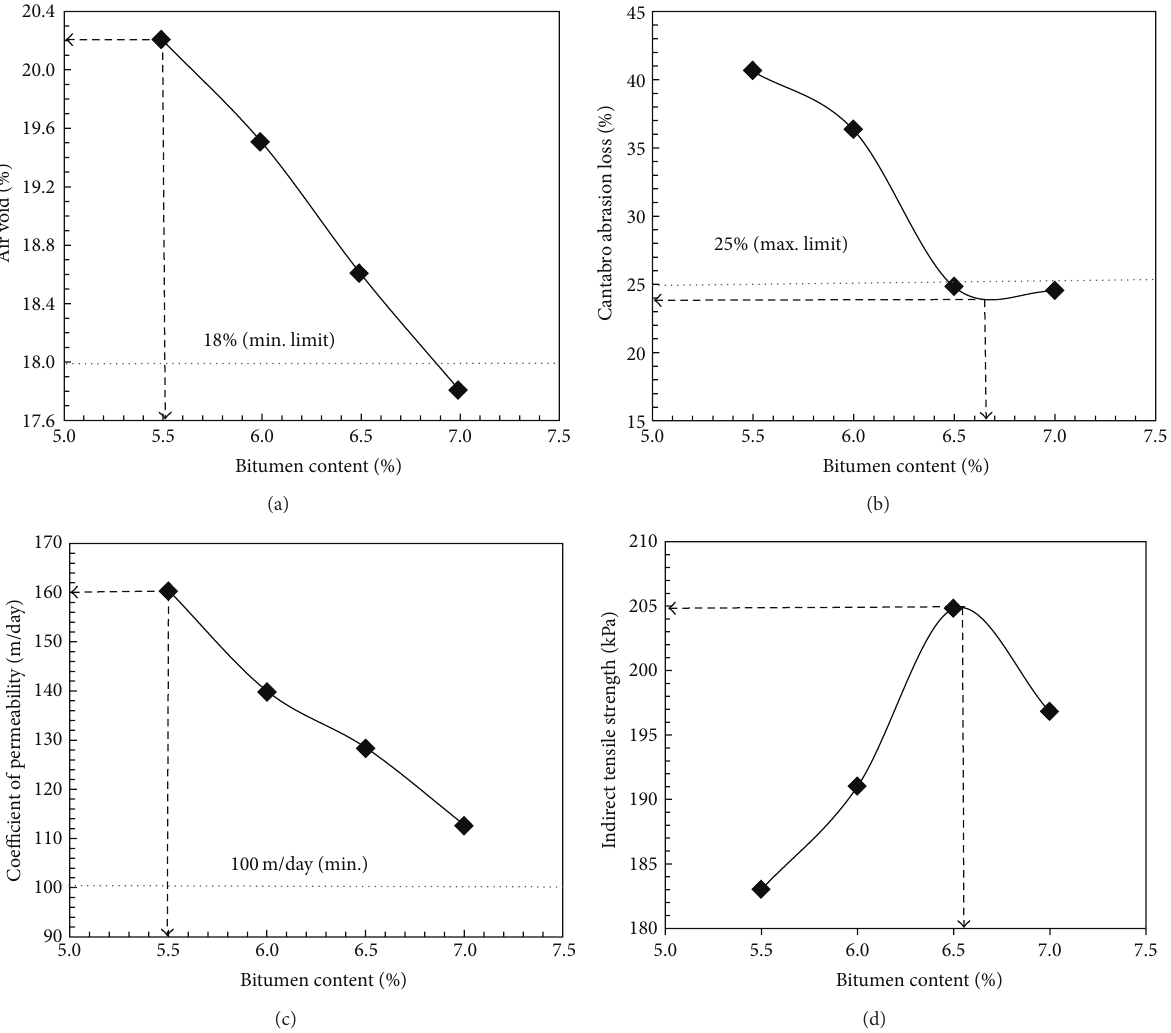
Figure 5: Graphics of mix design for porous asphalt mixtures: (a) air voids; (b) Cantabro abrasion loss; (c) coefficient of permeability; (d) indirect tensile